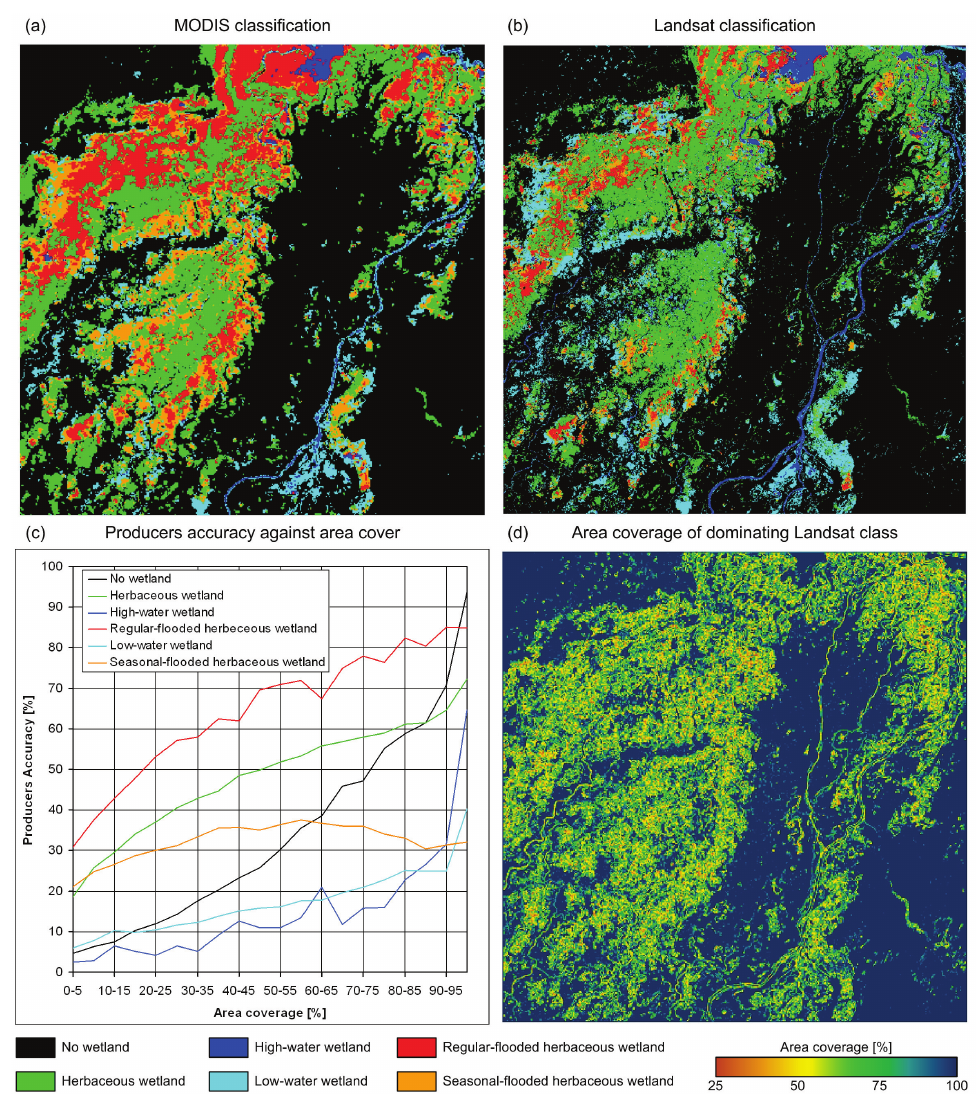
Figure 4. (a). Image classification result from the MODIS data. ( b). Image classification result from the Landsat data. ( c). Producers accuracies as a function of area-coverage in 5% intervals ( d). The area-coverage of the dominating